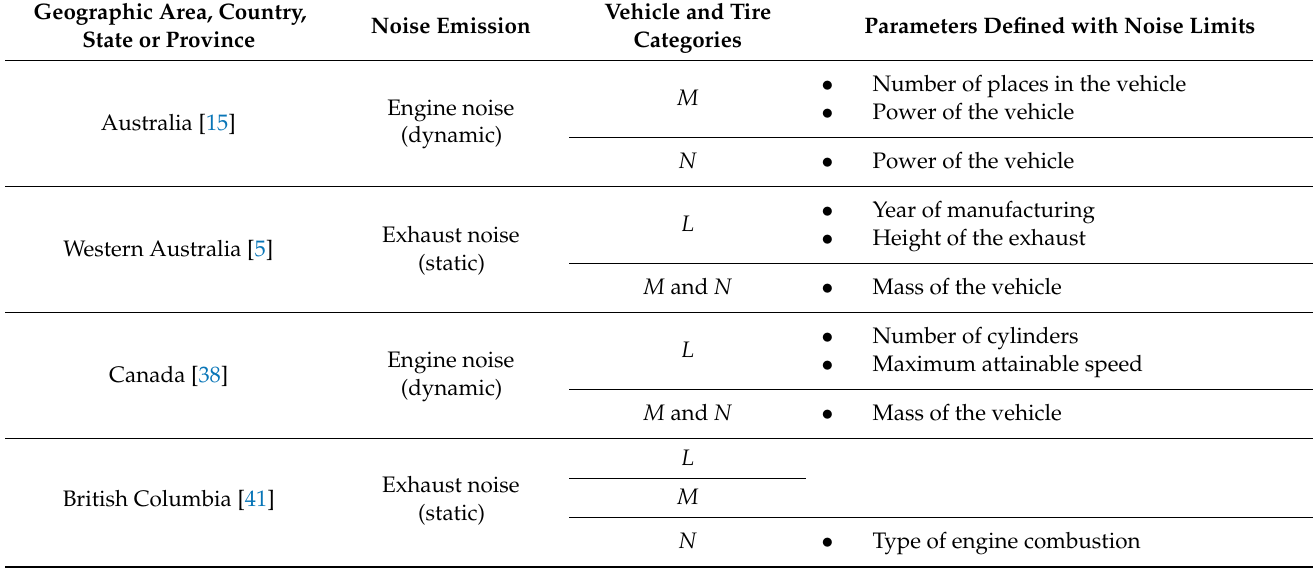
Table A1. Parameters defined according to the emission noise limits in regulations for engine, exhaust and tire